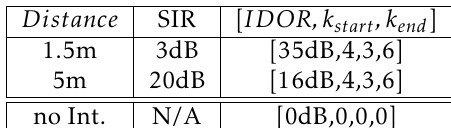
Table 1. ICOR index according to the measurements